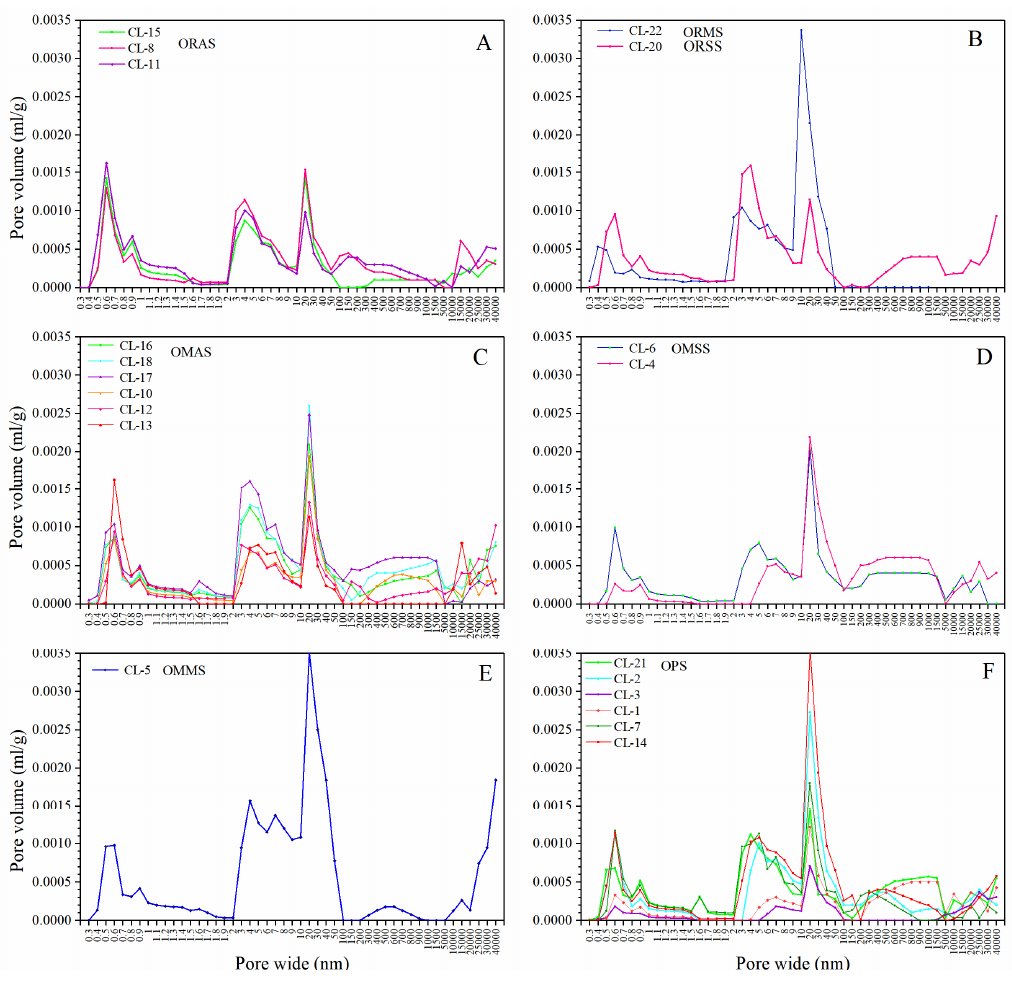
Figure 9. Full-size pore size distribution (PSD) characteristics of pore volumes of the Shahezi shales with different lithofacies in CFD. Table 4. Pore structure parameters of lacustrine shale samples with different lithofacies in CFD.